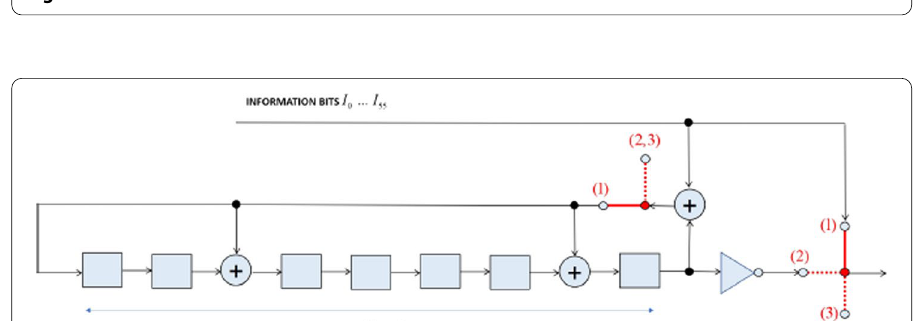
Fig. 4 8-Cell LFSR randomizer